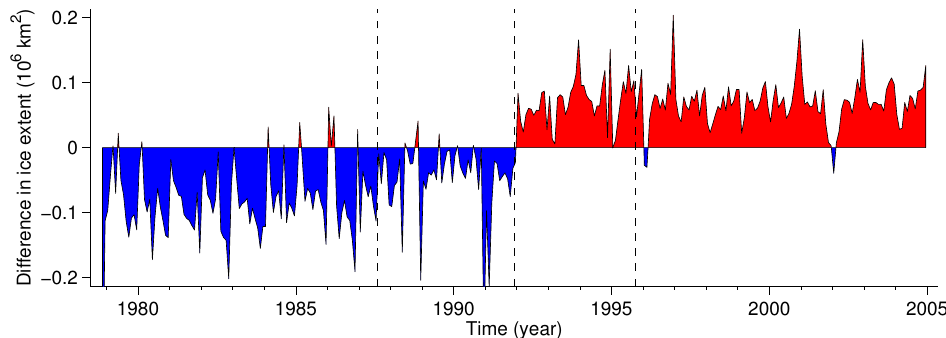
Figure 2. Difference between sea ice extents in the two Bootstrap data sets, plotted as Version 2 − Version 1. Both records are monthly- mean anomalies from the 1979–2004 mean seasonal cycle. Transitions between satellite sensors are indicated by vertical dashed lines (see Sect. S1.1 in the Supplement). The difference in ice extent appears to be dominated by a spurious jump in one of the data sets coinciding with the December 1991 sensor